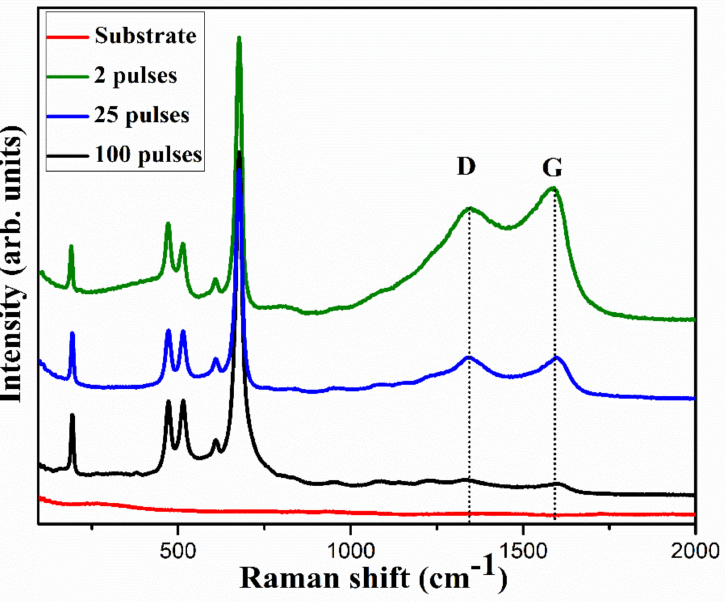
Figure 5. Raman spectra of the as-prepared electrodes, clearly showing the D and G peaks which represent the presence of defect and the graphitic phase of carbon,